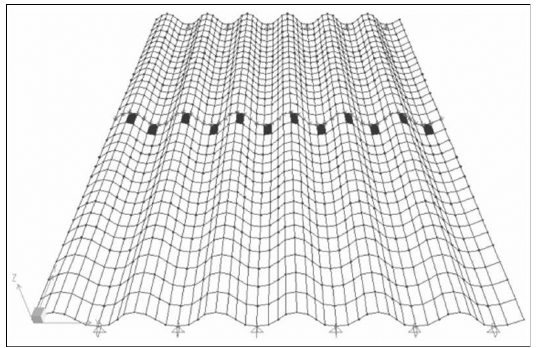
Figure 11. Finite elements in the central section of the sheet where the maximum stresses σ